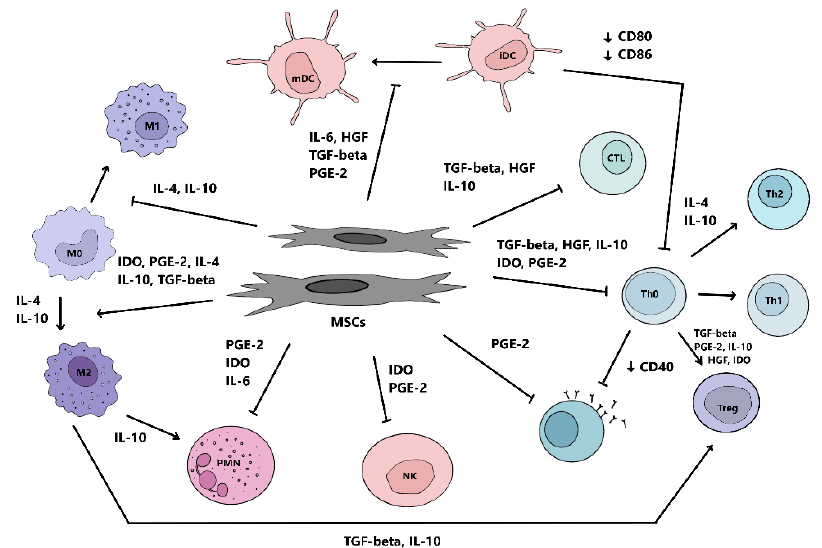
Figure 3. Interaction scheme between mesenchymal stem cells (MSCs) and the cells of the immune system. Activated MSCs secrete the following cytokines: prostaglandin E2 (PGE-2), indolamine 2,3-dioxygenase (IDO), nitric oxide (NO), and TGF- β . MSCs inhibit cytotoxic T cell proliferation and stimulate T helper (Th) cell production. The induction of Th2 differentiation and regulatory T cells (Treg) leads to the activation of an anti-inflammatory environment. Dendritic cell maturation (iDC) is inhibited by IL-6. At the same time, the expression of costimulatory molecules CD40, CD80 and CD86 acting to inhibit T cell activation is reduced. MSCs also act on monocytes, which target differentiation to the alternative anti-inflammatory phenotype M2, which is involved in the stimulation of Treg cells. MSCs are also able to inhibit NK cell proliferation, and to reduce their cytotoxic activity and cytokine secretion. They also suppress B cell proliferative activity, which leads to Ig secretion and production. Abbreviations: iDC, immature dendritic cell; IL, interleukin; HGF, hepatocyte growth factor; TGF- β , transforming growth factor- β ; PGE-2, prostaglandin E2; IDO, indoleamine 2,3-dioxygenase; NO, nitric oxide; PD-L1, programmed death ligand 1; MSC, human mesenchymal stem cell; Treg, T regulatory; Th, T helper; CTL, cytotoxic T cell; mDC, mature dendritic cell; PD-1, programmed cell death protein 1; PMN, polymorphonuclear leukocyte; NK, NK cell.